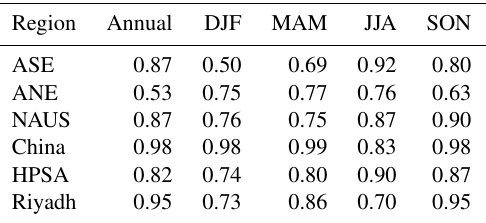
Table 4. Correlation between UV NO 2 SCDs and vis blue NO 2 SCDs for the six selected